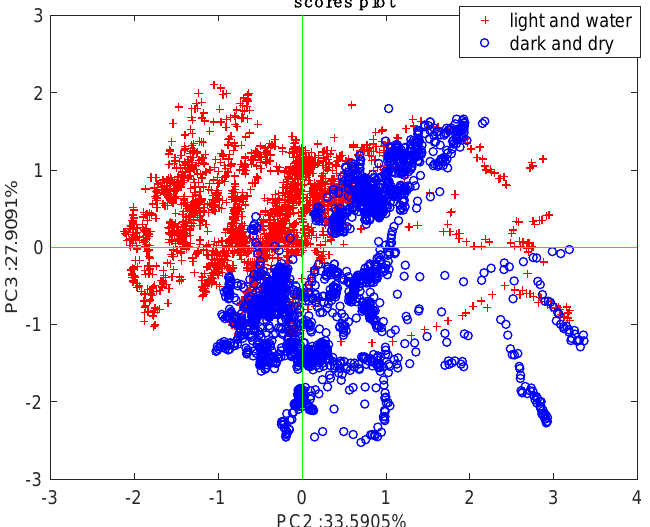
Figure 3. Behavior of the signals provided by the four sensors. Gas sensors experienced short failures.